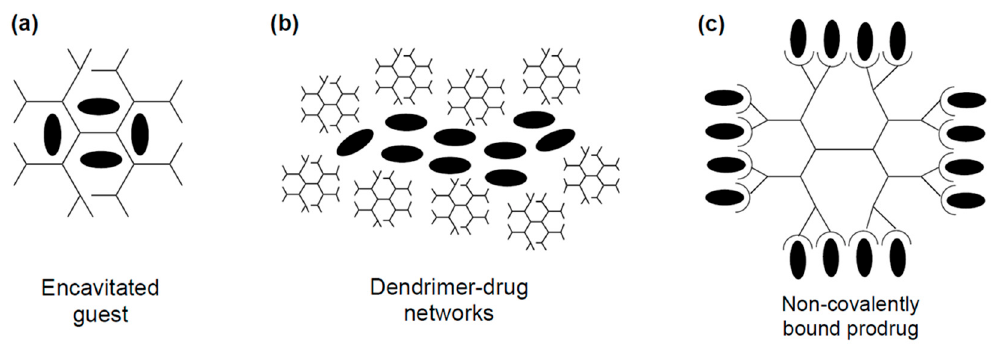
Figure 37. ( a ) Non-covalent unimolecular micelle behavior involving dendrimer-drug interactions, ( b ) non-covalent dendrimer aggregate-drug conjugates involving dendrimer-drug interactions and ( c ) non-covalent dendrimer-drug conjugates involving ionic surface interactions. Reprinted with permission from [111]. Copyright 2002 Elsevier.